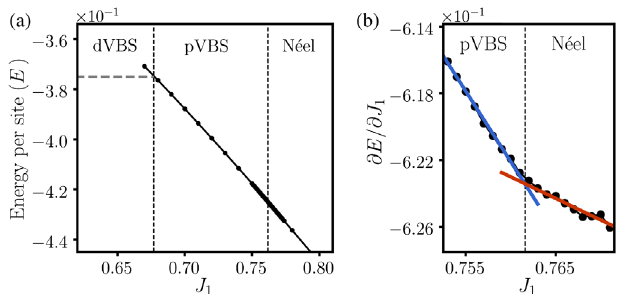
FIG. 3. At L ¼ 10 , χ ¼ 4000 . (a) Energy ( E ) per site. The horizontal dotted line represents the exact ground state energy of ¼ − 0 . 375 . (b) ∂ E= ∂ J the dimer VBS state, E 1 per site near the site transition between plaquette VBS and N´eel order. The continuous first-order derivative is a characteristic of the continuous phase transition. Black dashed lines denote phase boundaries among the dimer VBS, plaquette VBS, and N´eel